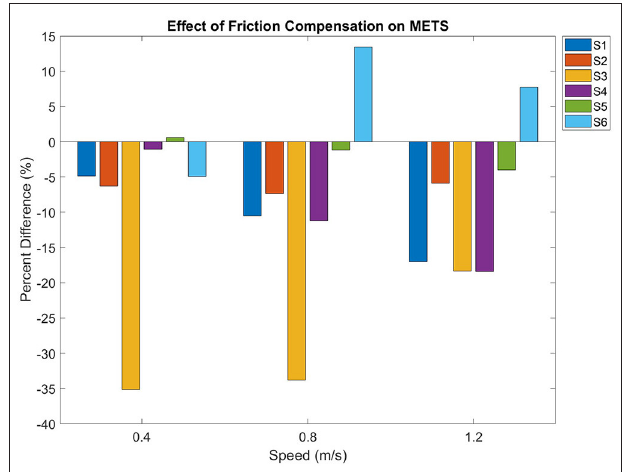
FIGURE 4 | METs percent difference between uncompensated and friction compensated conditions.